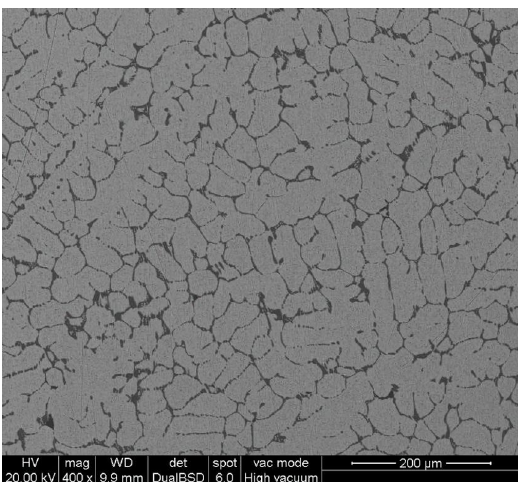
Figura 1. Microstructure of the CuNiSiCr alloy at as cast condition